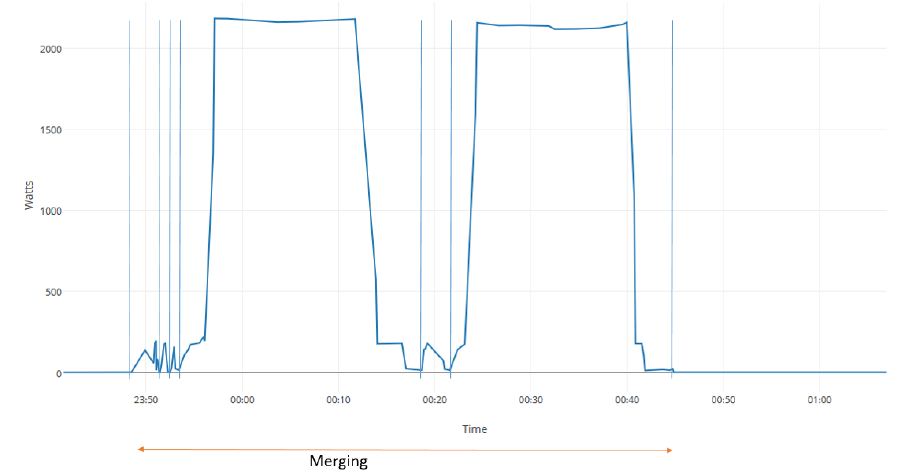
Figure 4. A washing machine consumption’s